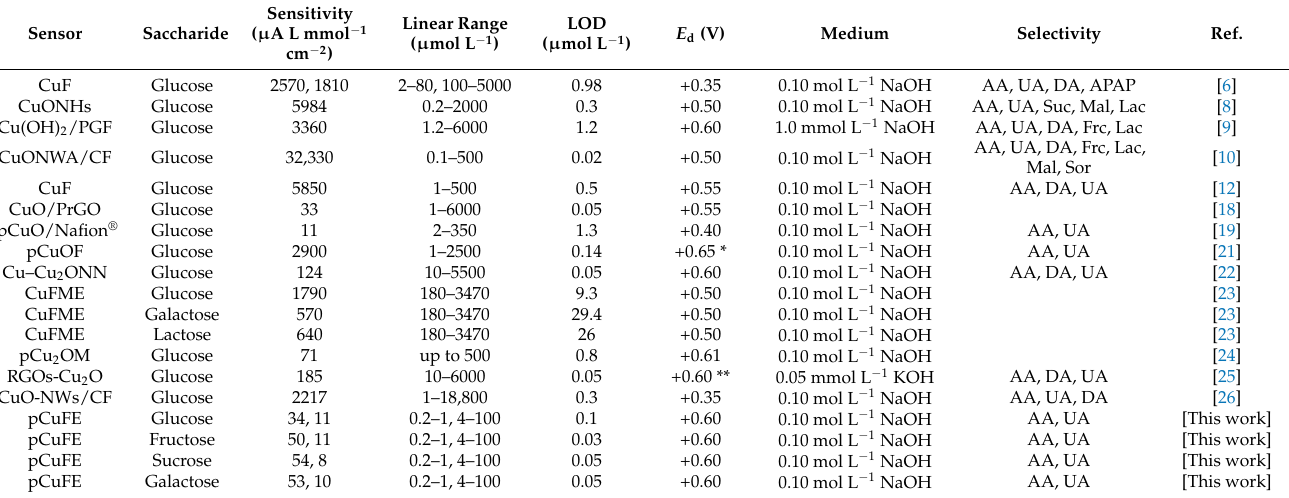
Table 1. Overview of non-enzymatic electrochemical detection of saccharides using porous copper- based